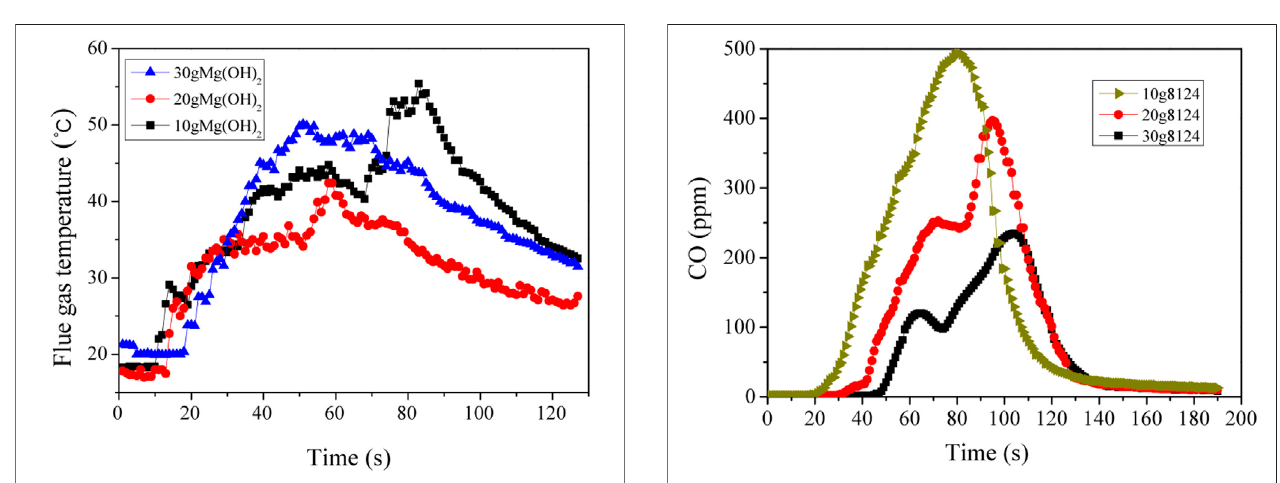
FIGURE 7 | CO concentration by using foam with 8124.